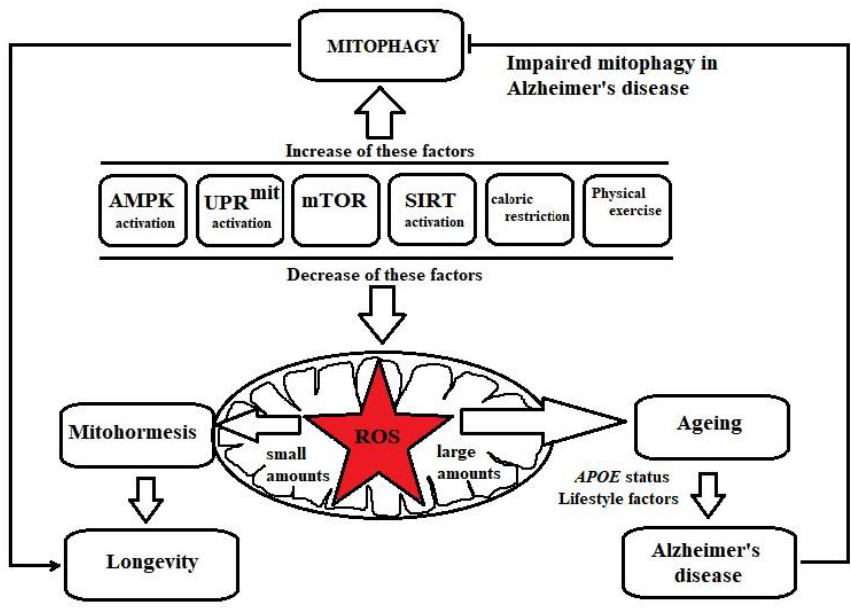
Figure 1. Factors regulating mitohormesis and mitophagy. Adenosine monophosphate (AMP)- dependent kinase (AMPK) signalling, mitochondrial unfolded protein response (UPRmit), Silent information regulator of transcription (Sirtuin) signalling, inhibition of mammalian target of ra- pamycin (mTOR), caloric restriction and physical exercise induce low levels of ROS in mitochondria. ROS, at low levels, activate stress resistance mechanisms (mitohormesis), resulting in longevity. However, increased amounts of ROS in mitochondria are responsible for ageing, which is a major risk factor for AD and is influenced by APOE status and a variety of lifestyle factors. AMPK signalling, UPRmit, Sirtuin signalling, mTOR inhibition, caloric restriction and physical exercise also induce the mitophagy process, which is defective in